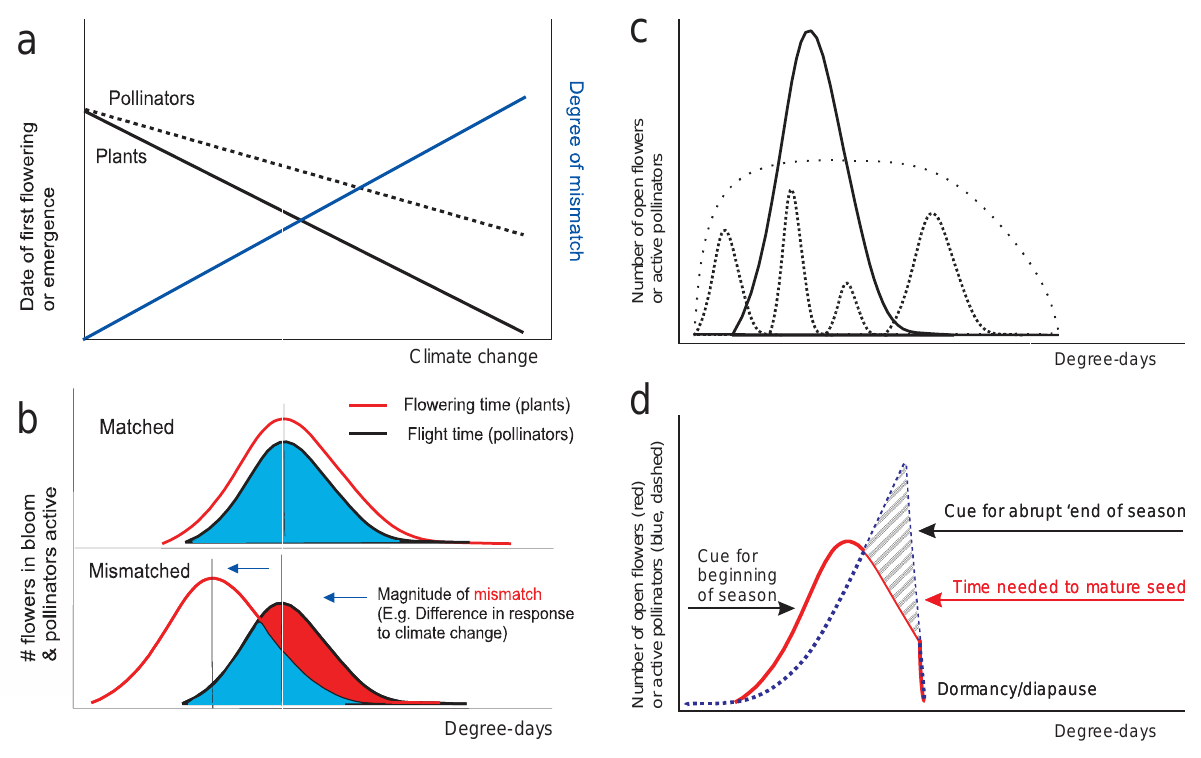
F IGURE 1. Simplified representations of (a) increasing phenological mismatches (space between lines) between plants and pollinators occurring when their changes in timing respond differently to climatic drivers through time, and (b) predicted consequences in relation to historical